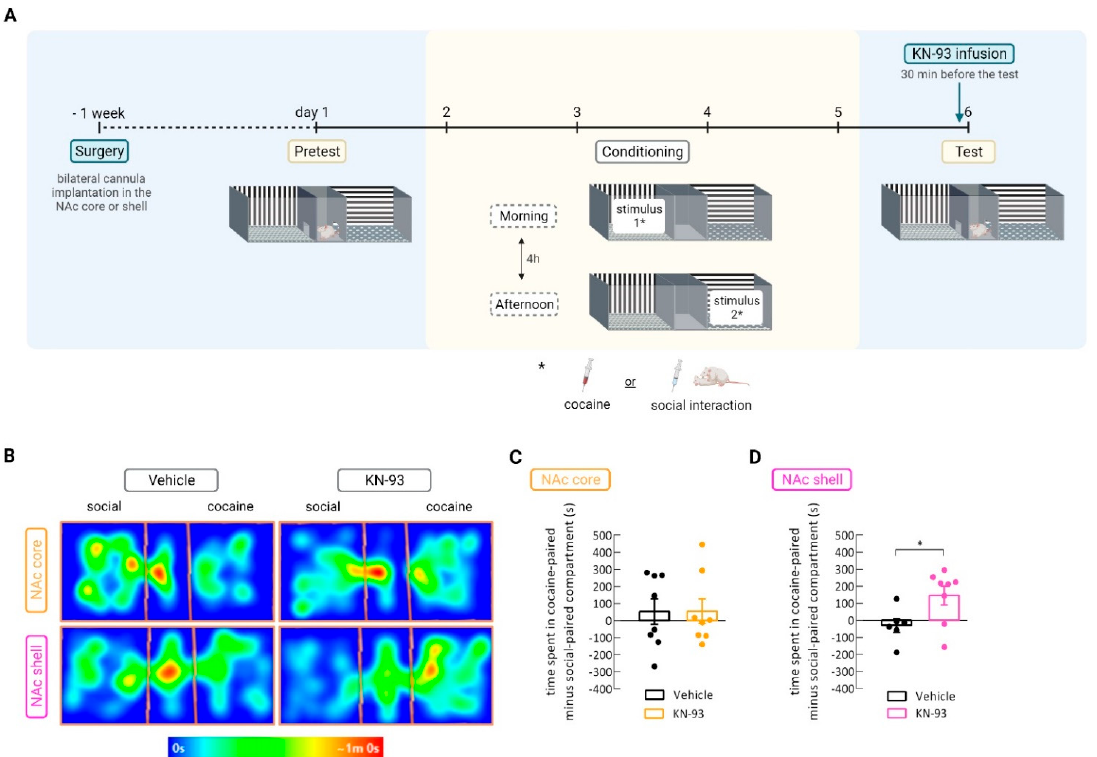
Figure 3. CaMKII inhibition in the NAc shell shifted the preference toward the cocaine-associated compartment. ( A ) Time- line. ( B ) Representative heatmaps of the time spent in each compartment during the CPP test of rats infused with vehicle or KN-93 in either the shell or core NAc subregions. “Social” and “cocaine” refer to the compartment side of the apparatus where the animals were conditioned with the stimulus before being tested for CPP. ( C ) Difference between the time rats spent in the cocaine- and in the social-associated compartments during the CPP test for rats infused with either vehicle or KN-93 in the NAc core; p = ns; n = 8. ( D ) Difference between the time rats spent in the cocaine- and in the social-associated compartments during the CPP test for rats that received an infusion of either vehicle or KN-93 in the NAc shell; * p < 0.05, unpaired t -test; n = 6–10. Results are presented as mean ± SEM.